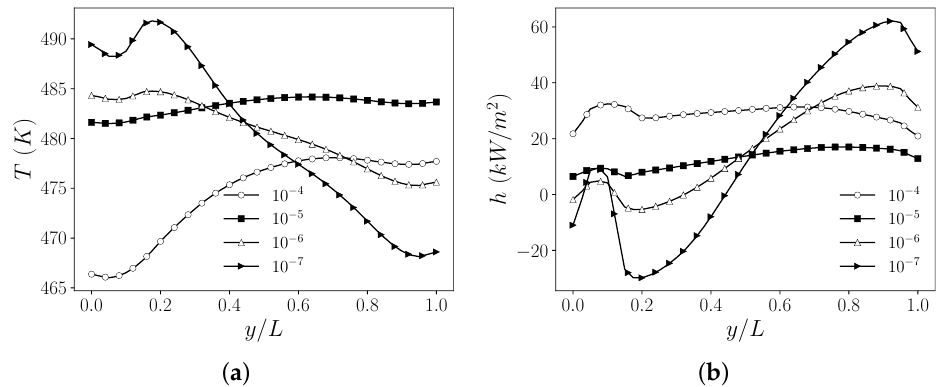
Figure 11. Velocity matching case with Neumann boundary control: temperature T ( a ) and wall- normal heat flux h ( b ) plotted against y / L on the controlled boundary Γ c . Numerical results for λ = 10 − 4 ,10 − 5 ,10 − 6 , and 10 − 7